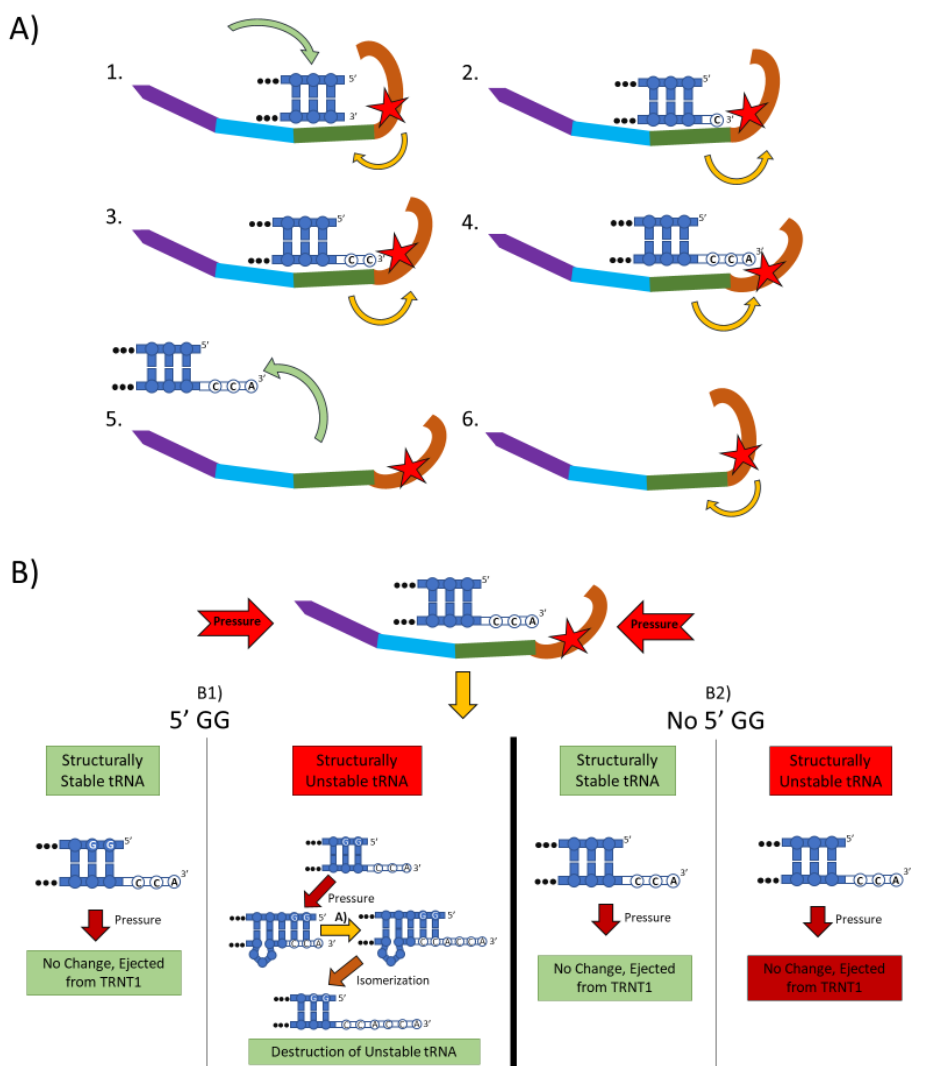
Figure 1. The two main functions of the TRNT1 enzyme: CCA addition, and tRNA quality control through CCA addition. ( A ) CCA addition. TRNT1 enzyme pictured with domains colored as: head (orange), neck (green), body (blue), and tail (purple). Additionally, the catalytic site is visualized by the red star, with the white nucleotides representing the end of the acceptor stem of the attached tRNA, and the yellow arrows indicating movement between the head and neck domains. (A1) tRNA binds with TRNT1 forming an RNA–protein complex. (A2) Cytosine is incorporated in a template-independent manner to the 3 (cid:48) end of the tRNA, resulting in a conformational change in the TRNT1 enzyme. (A3) A second cytosine is added to the growing 3 (cid:48) end of the tRNA, resulting in an additional structural shift in TRNT1. (A4) The terminal adenine is added to finish the CCA addition, and the structural integrity of the tRNA is judged. (A5) The RNA–protein complex dissociates and the tRNA is ejected from TRNT1. (A6) TRNT1 resets to its resting conformation. ( B ) tRNA quality control. During the addition of the CCA end to the tRNA, the TRNT1 exerts pressure on the tRNA, which can result in one of four outcomes. (B1) If the tRNA has two guanines on its 5 (cid:48) end and the tRNA is structurally unstable, the pressure from TRNT1 will force the recently created CCA end to slide back and create a bubble of nucleotides. This allows for the addition of a second CCA end, tagging the tRNA for destruction. If the two 5 (cid:48) guanines are present and the tRNA is structurally sound, then no bubble will form and no second CCA will be added. (B2) If there is no GG present on the 5-prime end of the tRNA, when the pressure is exerted from the TRNT1, no bubble is formed and the tRNA is ejected from the RNA–protein complex. This will occur whether the tRNA is structurally stable or